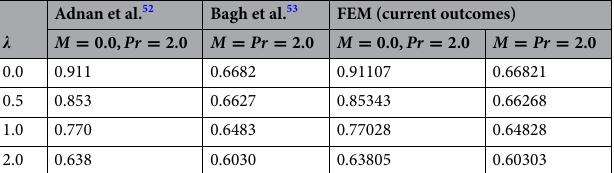
θ ′ ( 0 ) for different inputs of (cid:31) at ξ